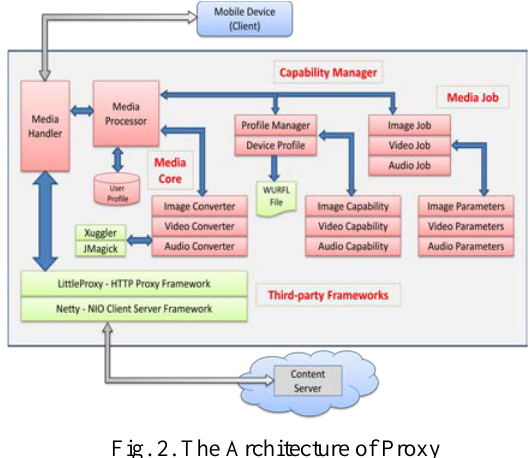
Fig. 2. The Architecture of